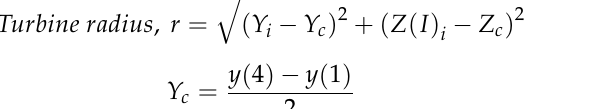
Table 1. List of Telemac3D subroutines used in this study and their corresponding functions.